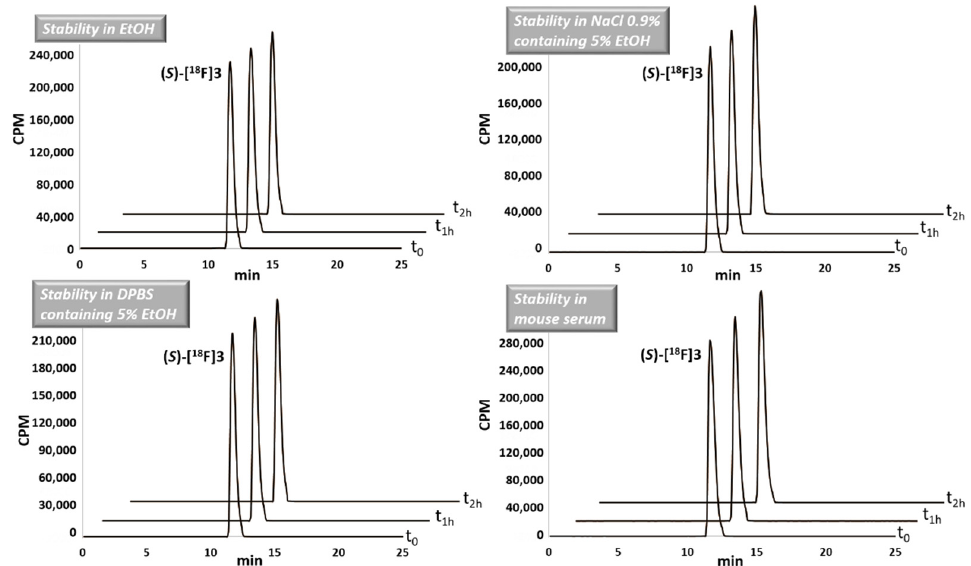
Figure 8. Radioactivity-HPLC chromatograms of the radiotracer ( S )-[ 18 F] 3 incubated, for 0, 1, and 2 h post formulation, at room temperature in ethanol, NaCl 0.9% containing 5% ethanol, and DPBS (pH 7.4) containing 5% ethanol, as well as in a mixture of DPBS and mouse serum at 37 °C.